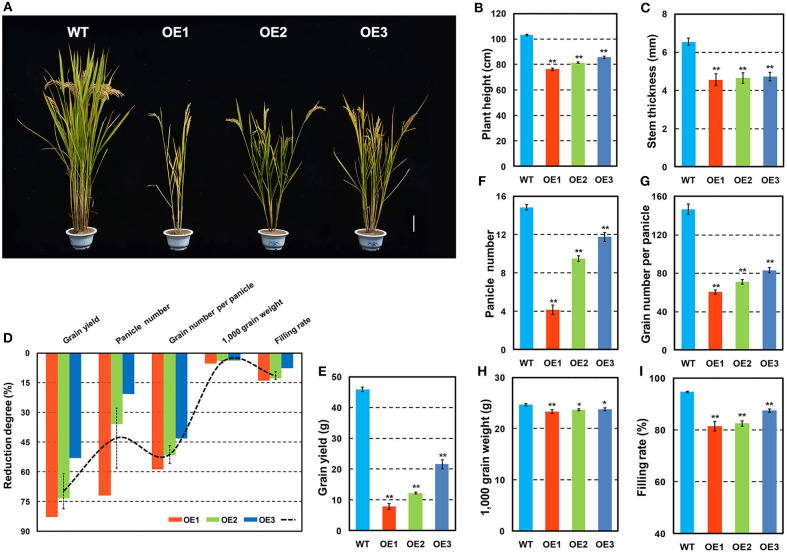
Phenotypes and yield related traits of OsCKX2 OE rice and WT at mature stage. Plant morphology at mature stage (A). Statistical analysis of plant height (B), stem thickness (C), reduction degree of yield related traits (D), grain yield (E), panicle number (F), grain number per panicle (G), 1,000 grain weight (H), and filling rate (I). Data represents means ± SEM (n = 15). **P < 0.01, *P < 0.05. Scale bars: 10 cm.